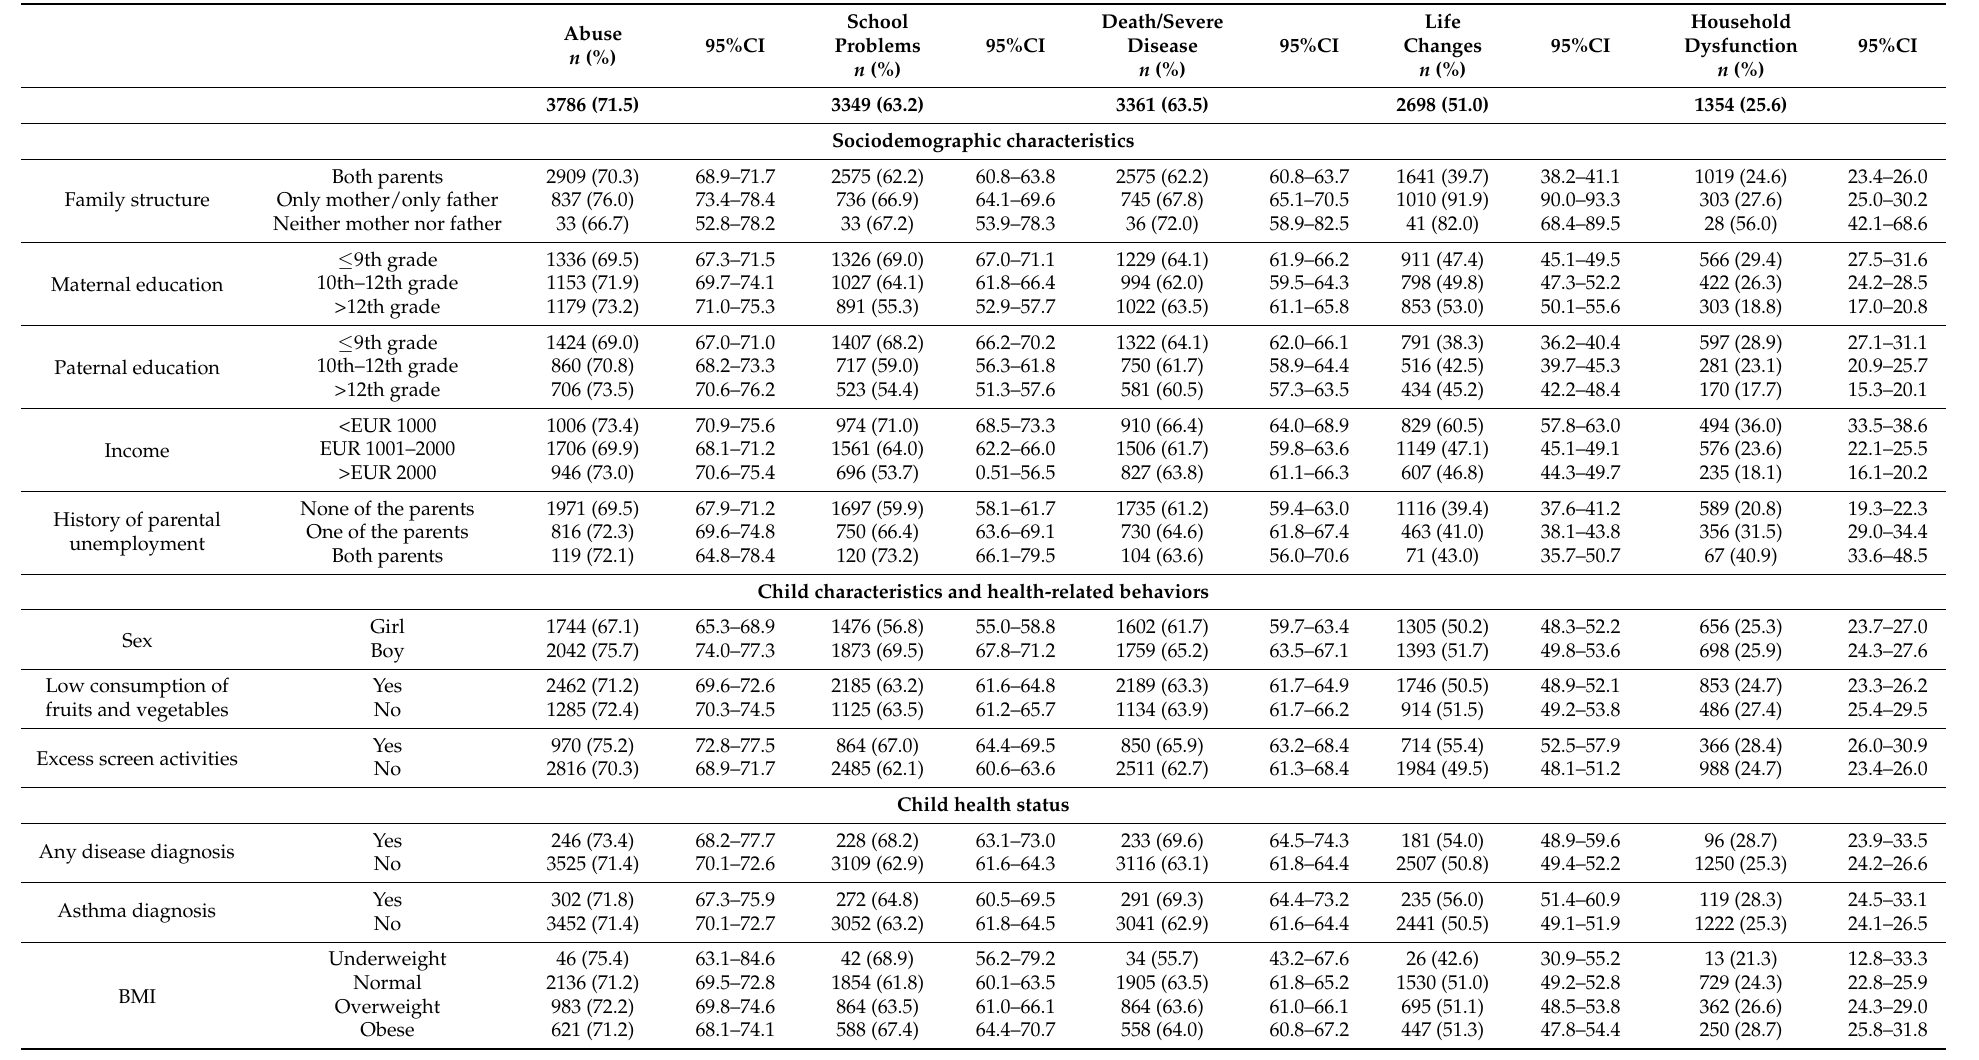
Table 2. Descriptive characteristics of sample according to the five ACEs’ dimensions from principal component